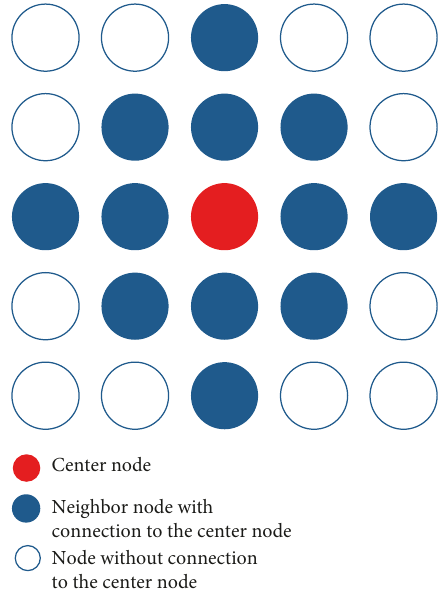
Figure 2: Nodes and neighbor nodes. Blue represents the node has edge to the red node. White represents the node has no edge to the red